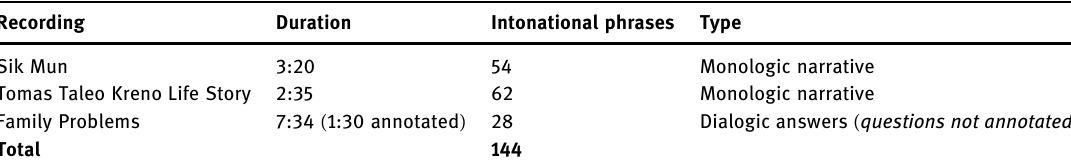
Table 2: Intonational phrases annotated in our corpus